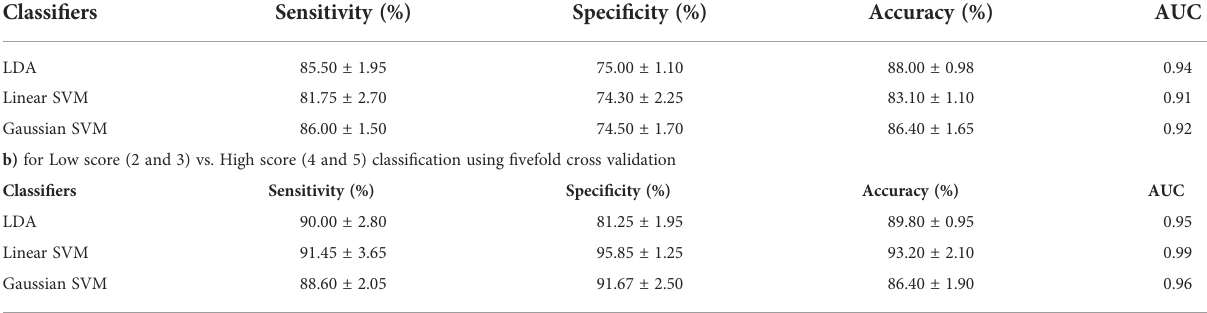
TABLE 2 Classi fi cation performance of the proposed model a ) for Score 2 vs. Score 3 vs. Score 4 vs. Score 5 classi fi cation using 5-fold cross-validation.